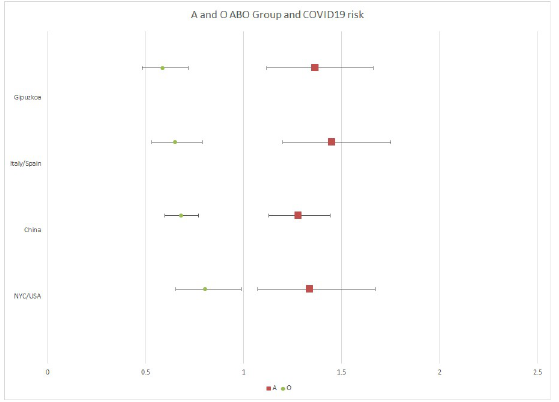
Fig 1. Odd ratio of A (red square) and O group (green circle) from our study and the ones found in the literature.